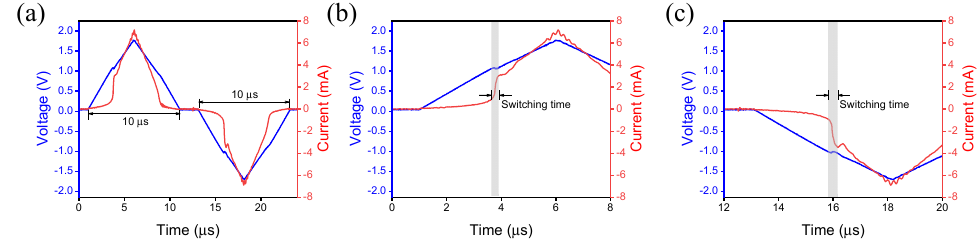
Figure 5. ( a ) The triangular pulse with 10 µm of pulse width, ( b ) switching time at positive bias, ( c ) switching time at negative bias.